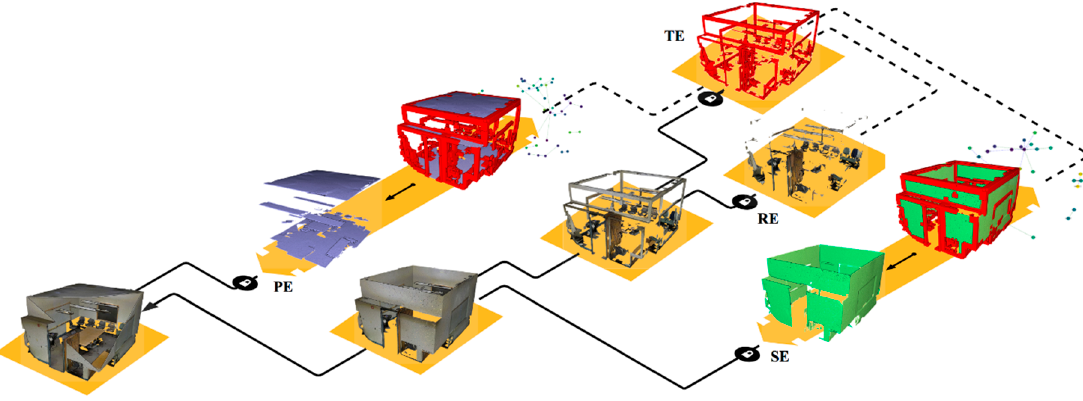
Figure 11. Elements detection and categorization. A point cloud is search for Primary Elements (PE), the rest is searched for Secondary elements (SE). The remaining from this step is searched for transition elements (TE), leaving remaining elements (RE). TE permits extracting graphs through SF2 analysis with PE, SE, and RE.